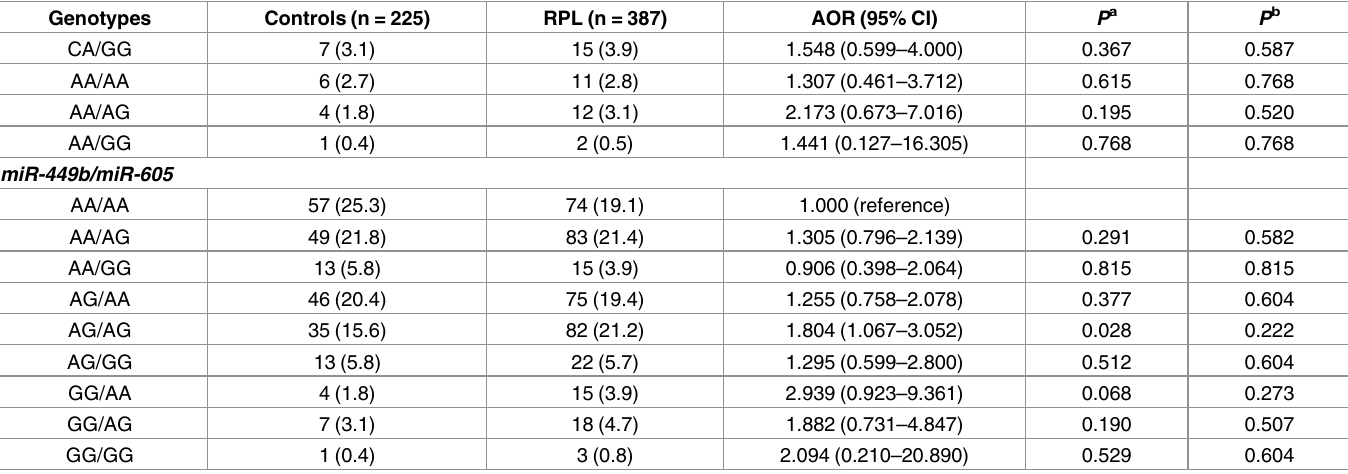
reference genotypes when variant genotypes were located in the loci of miR-423 , miR-449b , and miR-605 . These results were consistent with associations between a RPL risk and individ- ual microRNA genotypes; however, each association was not significant after the FDR correc- tion for multiple comparisons, suggesting a weak association. Haplotype-based analyses of the four microRNA polymorphisms for gene-gene interactions are shown in S1 Table (all possible allele combinations) and Table 4 (allele combinations suggesting associations with RPL). Inter- action models suggested by the MDR were evaluated using haplotype-based analyses. Among the models of the four polymorphic loci, the G-C-A-G haplotype (OR = 0.525; 95% CI = 0.321–0.859) was associated with a decreased RPL risk whereas three haplotypes, A-C-G-A (OR = 1.870; 95% CI = 1.178–2.968), A-A-A-G (OR = 2.429; 95% = 1.153–5.114), and G-C-G-G (OR = 3.214; 95% CI = 1.441–7.172), were associated with an increased RPL risk. Among the models of the three polymorphic loci, one haplotype, G-A-G of miR-27a/miR-